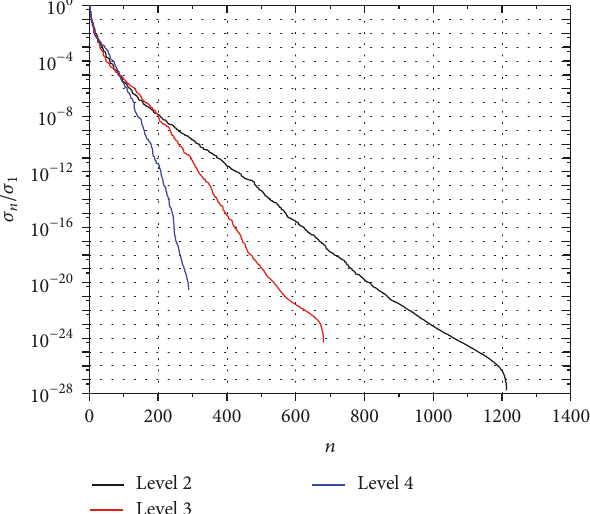
Figure 3: Normalized singular values of the reduced translation matrix.